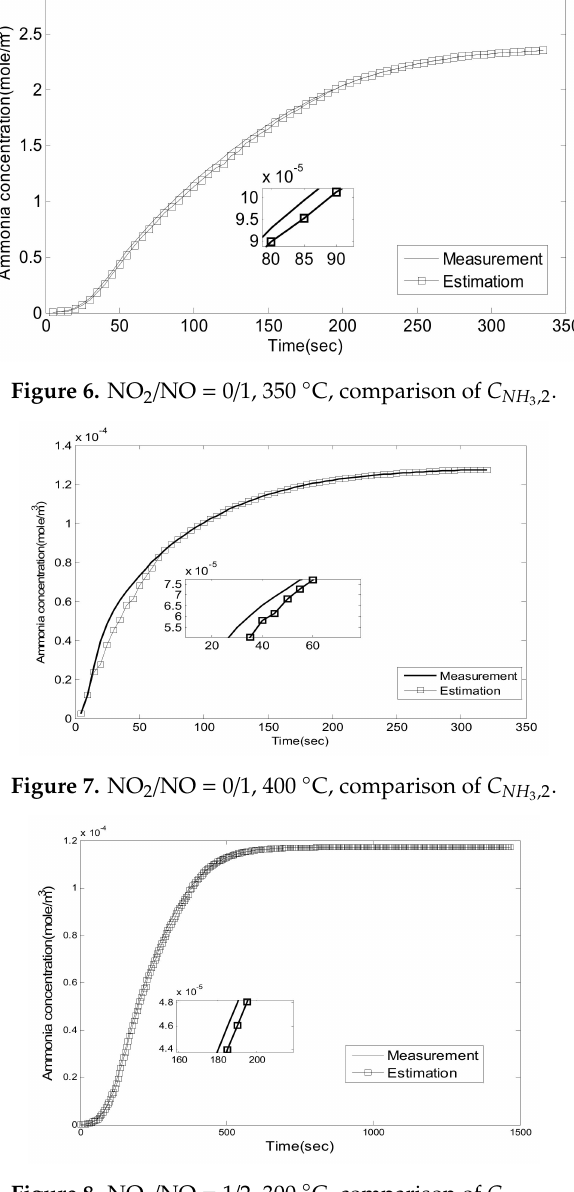
Figure 8. NO 2 / NO = 1 / 2, 300 ◦ C, comparison of C NH